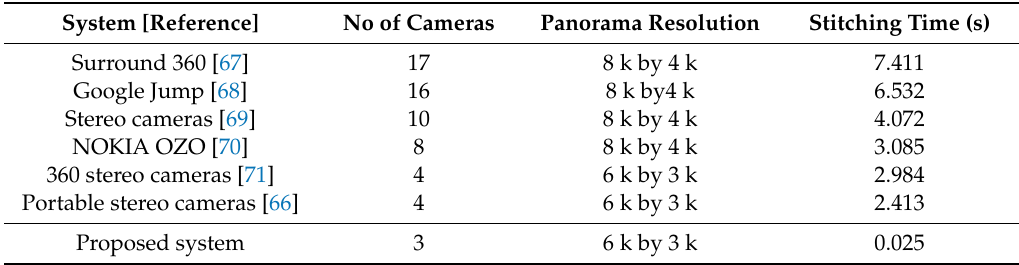
Figure 14. The obtained SSIM, PSNR, and RMSE score of our proposed method against Lin et al. [66] system. Table 5. Comparison of our proposed system with state-of-the-art stereo panorama generation hardware systems.